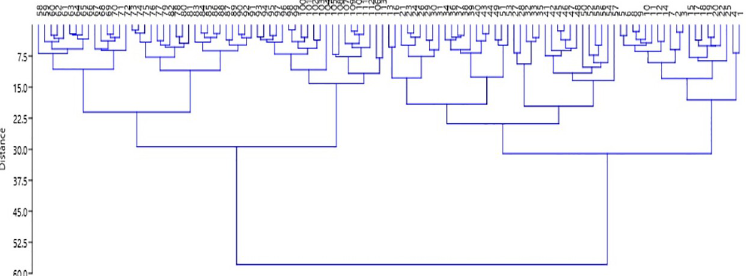
Fig 3. A UPGMA cluster dendrogram of 113 aromatic rice germplasm based on 4 physio-chemical traits using Ward’s